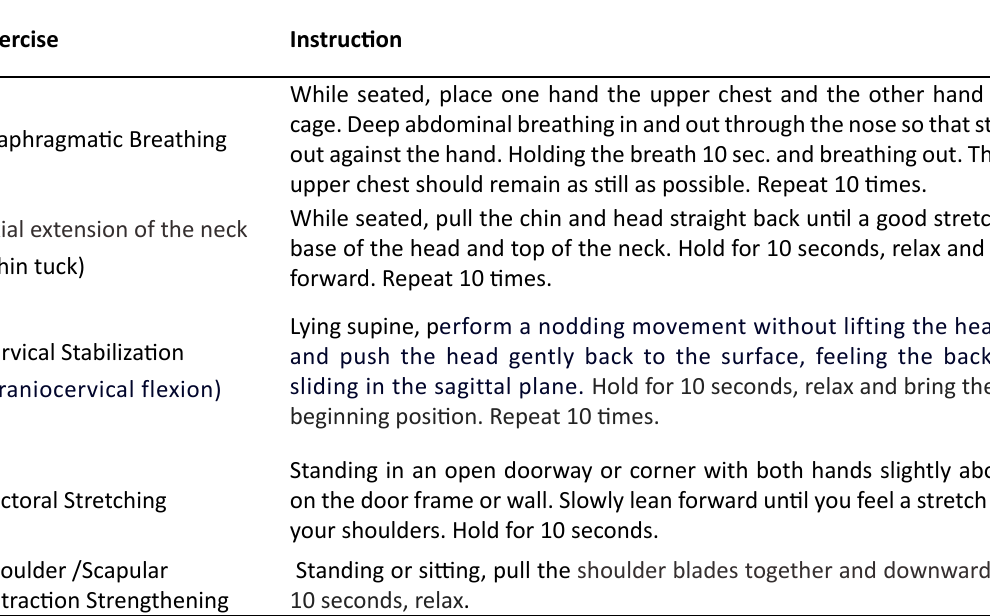
Table 2. Descriptive data of the students Characteristics